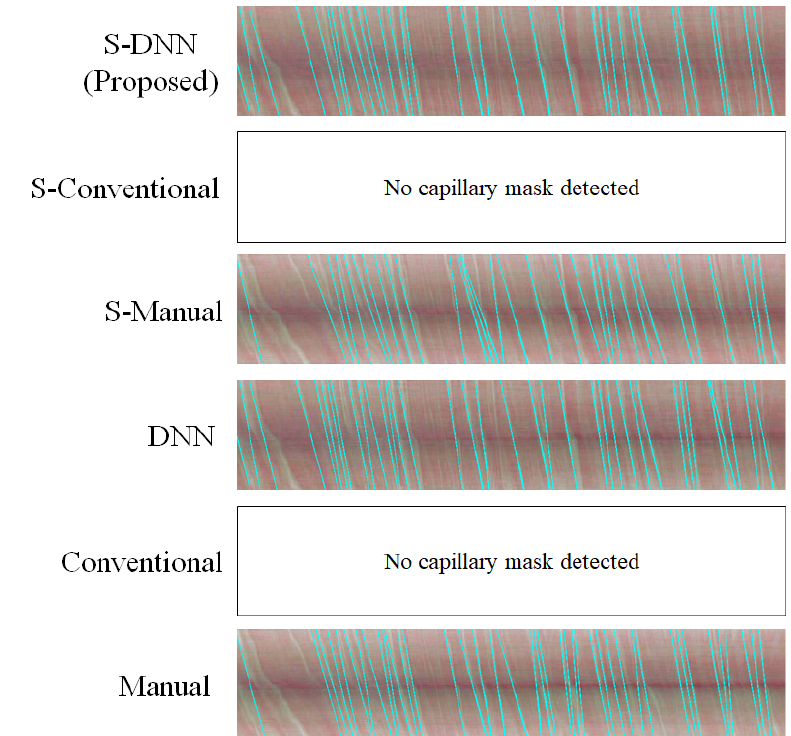
Figure A5. Events reconstructed from event counting using various methods for capillary 5.